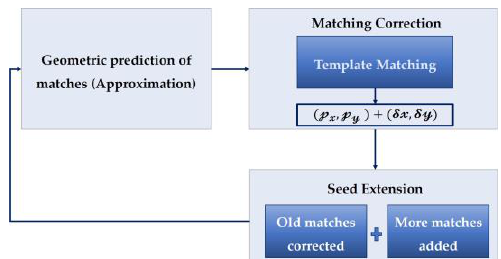
Figure 2. The recursive method: the geometric prediction of point correspondence and the correction by template matching